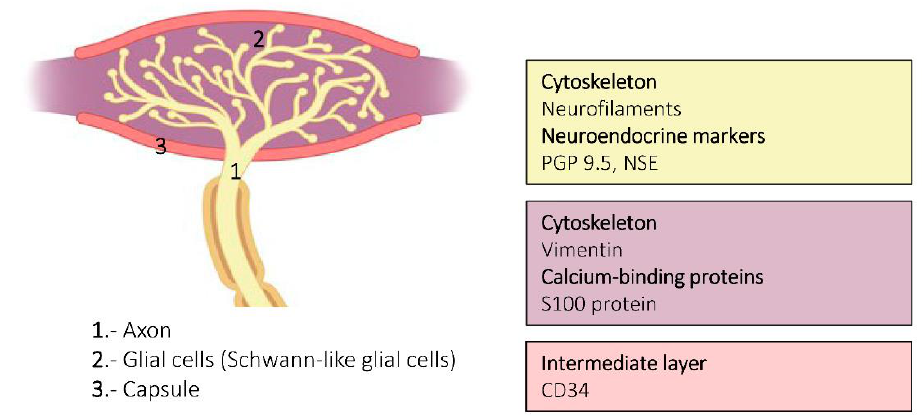
Figure 6. Schematic representation of Ruffini corpuscles showing the proteins detected in the different corpuscular components using immunohistochemistry. Axon: yellow box; lamellar cells: purple box; capsule: pink box.